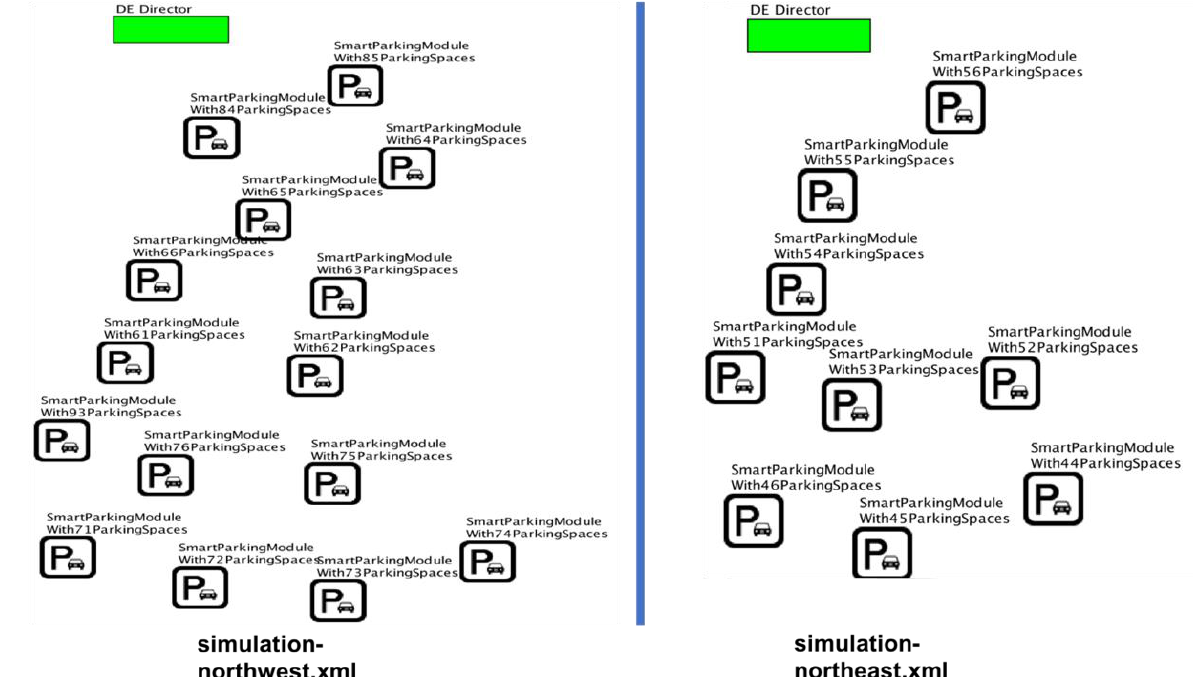
Figure 25. Modular and hierarchical distribution to model an IoT parking system for the city of Madrid.